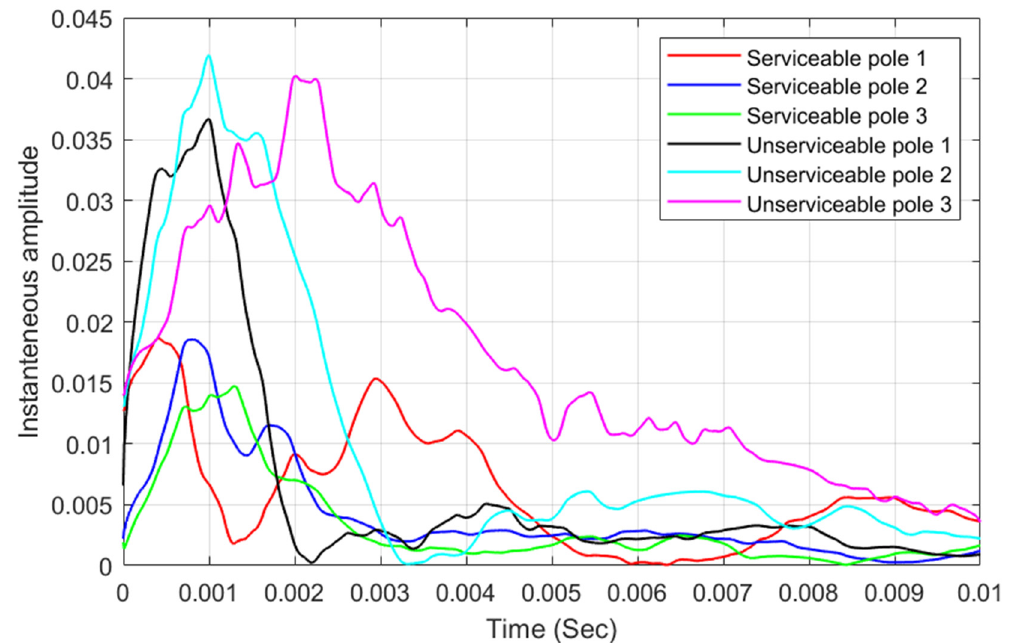
Figure 21. Instantaneous amplitude of IMF1 for A0R2 considering 3 serviceable poles and 3 unserviceable poles.